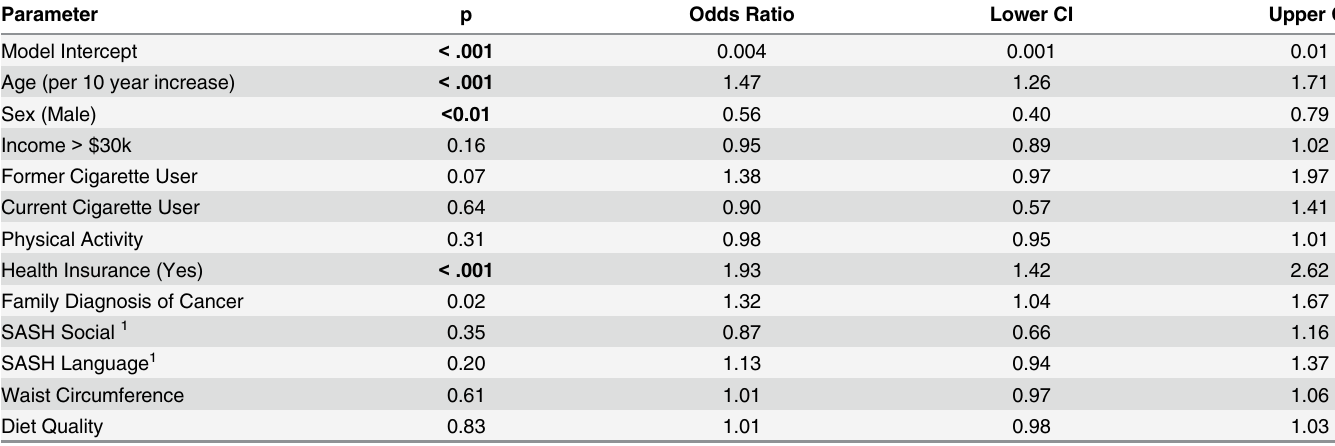
Table 2. Logistic Regression Odds Ratios for Covariates on Cancer Prevalence for Model containing all Hispanics (N =